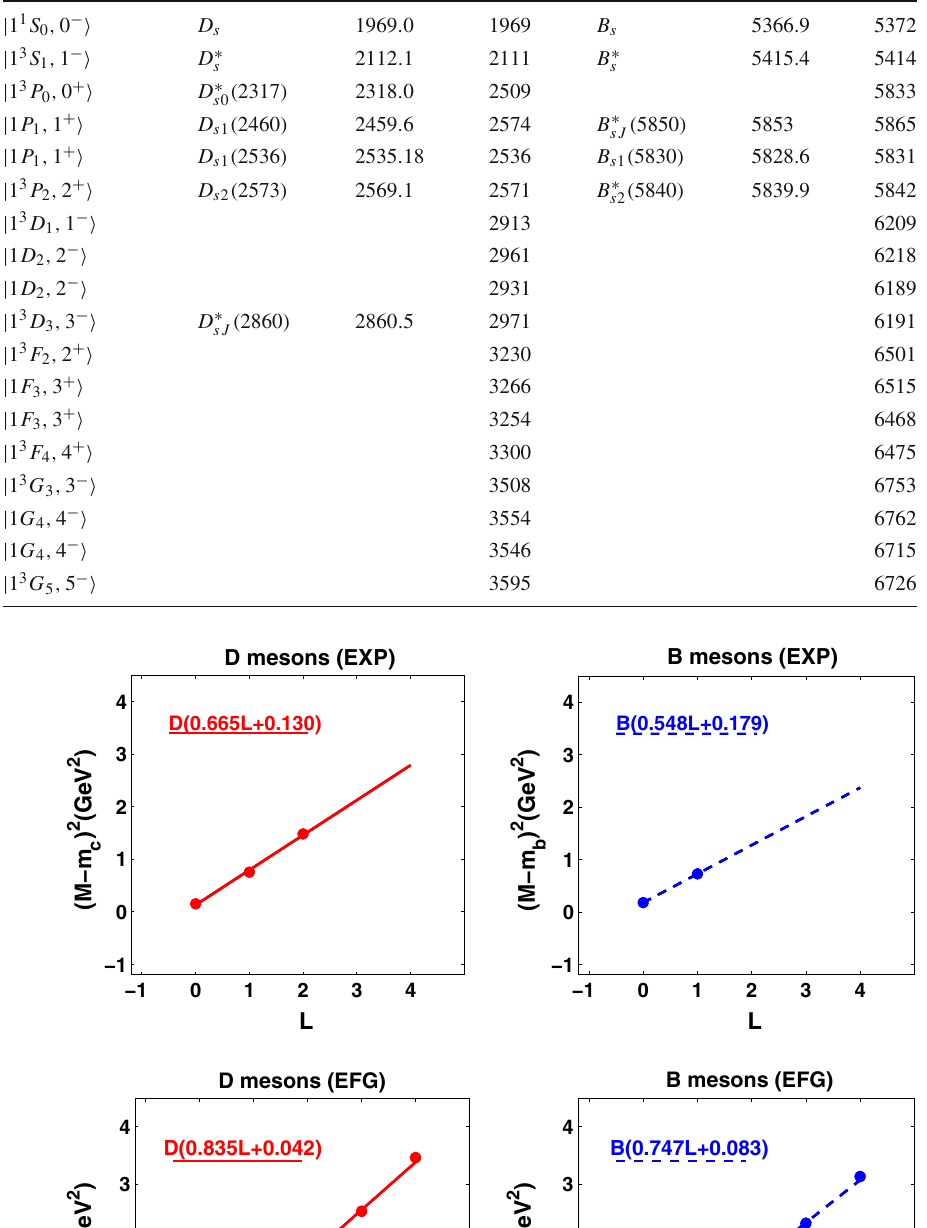
Fig. 3 Plots of values calculated in Ref. [17] similar to Fig. 2. The best fit lines are given with